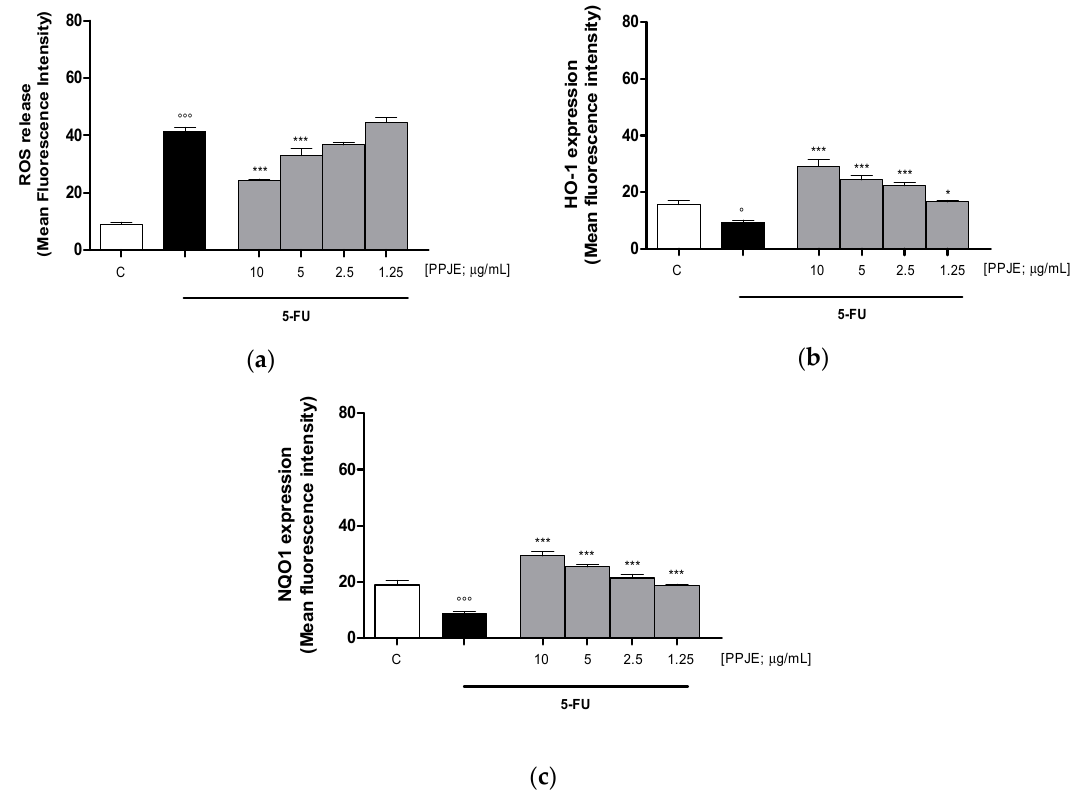
Figure 4. Effect of PPJE (10–1.25 μ g/mL) on the inhibition of intracellular ROS release ( a ), detected by 2 ′ ,7 ′ dichlorofluorescein-diacetate (H 2 DCF-DA), and on the increased expression of the antioxidant proteins HO-1 ( b ) and NQO1 ( c ), detected by flow cytometry, on 5-FU-treated IEC-6. Data are expressed as mean fluorescence intensity. C denotes control group. *** and * denote respectively p < 0.001 and p < 0.05 vs. 5-FU; °°° and ° denote respectively p < 0.001 and p < 0.05 vs. C.